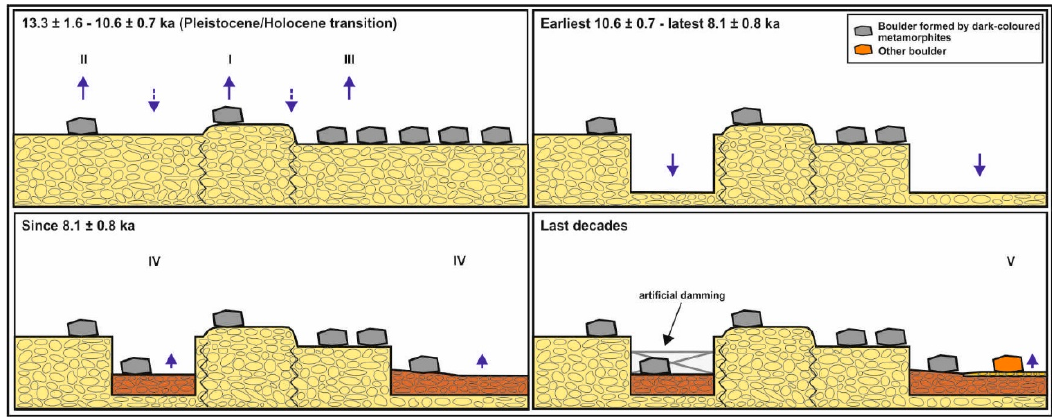
Figure 10. Schematic model of the evolution of the present-day alluvial fan since ca. 13 ka (location in the river system please see Figure